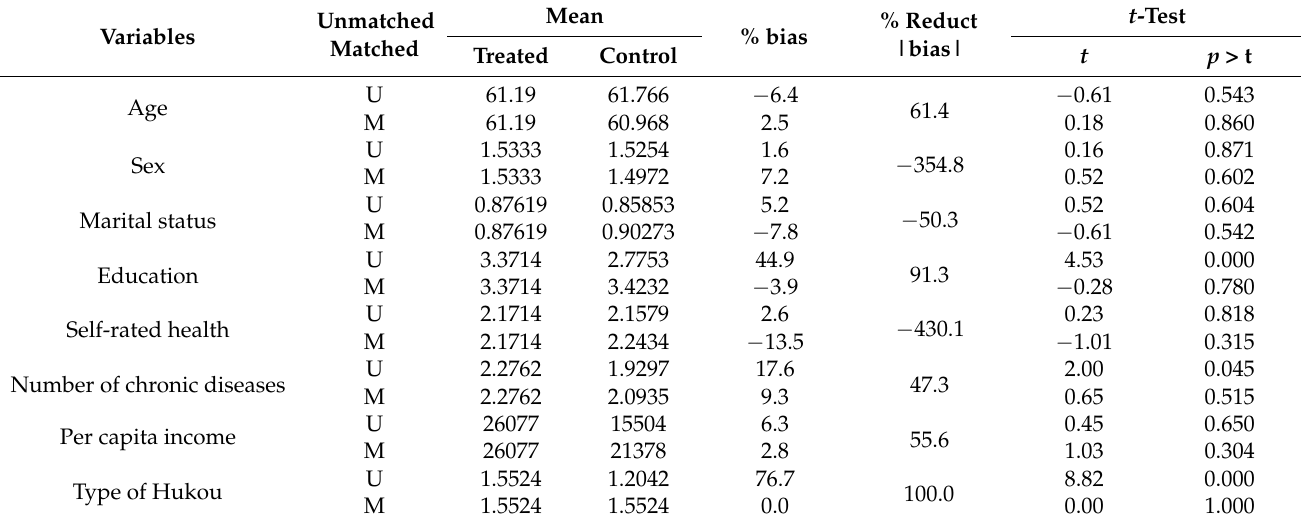
Table 3. k-nearest neighbor matching (k = 10) balance